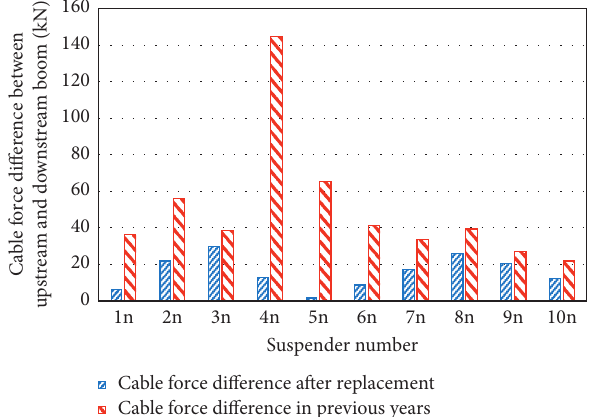
Figure 28: Cable force difference between upstream and down- stream inner suspenders of the same number.